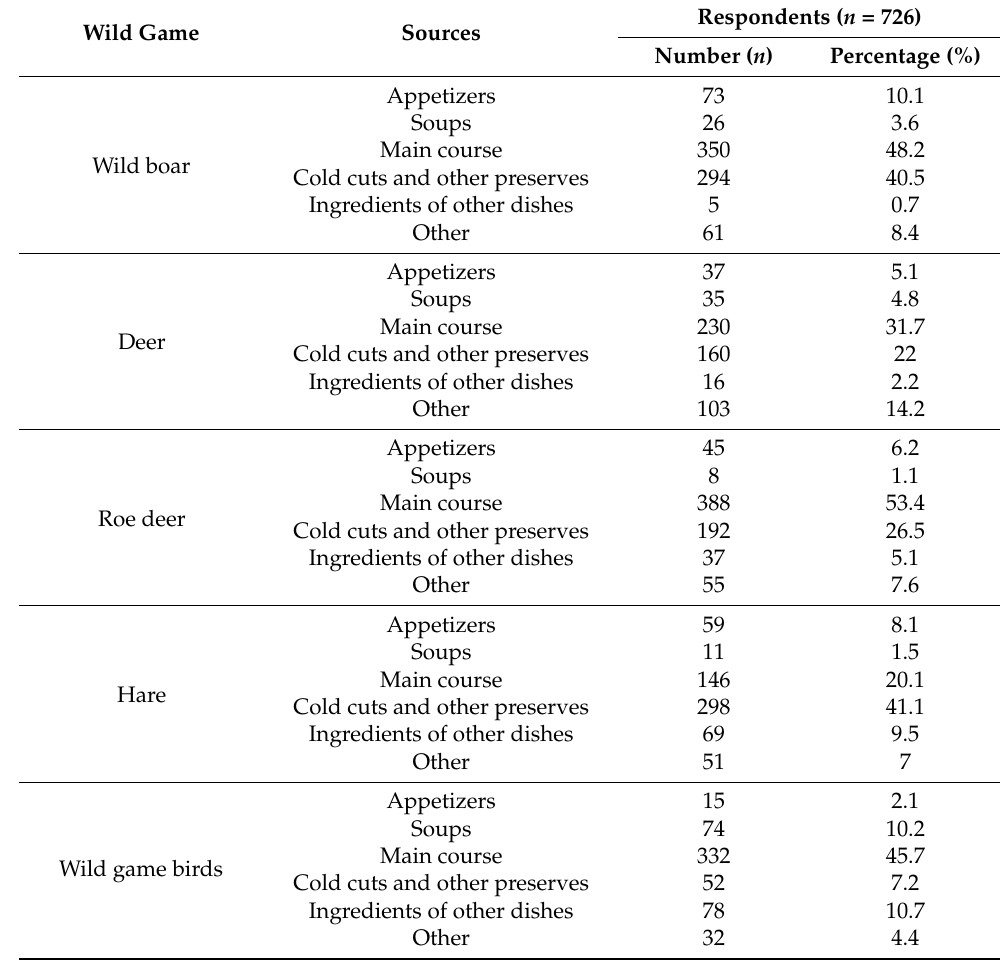
Table 3. Wild game consumption and meals prepared from